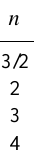
Table 2. B values used by Gardner (1958) for determining capil- lary flux as a function of soil index, n (see Eq. 16). The analytical solution of Gardner (1958) assumes a completely dry surface, and the B values listed here are similar to those calculated by means of Eq. (17) (which is used in the G-E